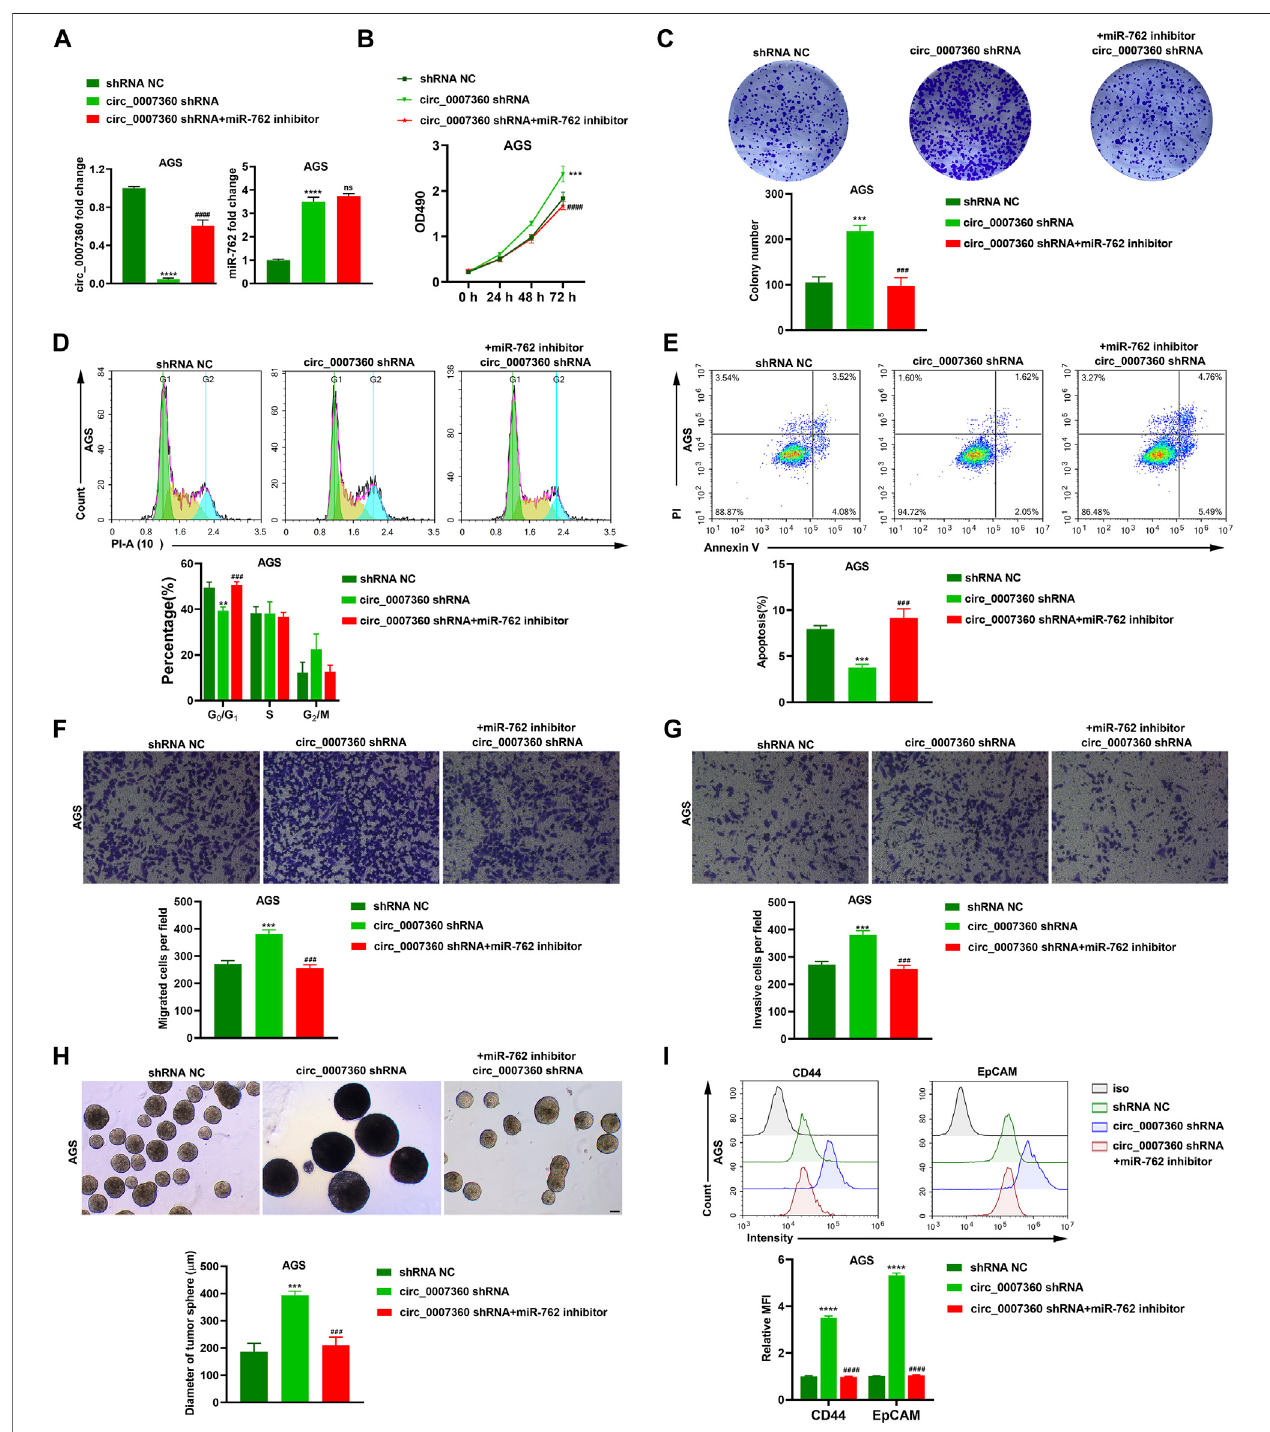
FIGURE 6 | Inhibition of miR-762 is responsible for the tumor-suppressive role of circ0007360 . (A) RT-qPCR analysis of circ0007360 or miR-762 expression with circ0007360 knockdown and miR-762 re-expression in AGS cells. (B) MTT assay in AGS cells with circ0007360 depletion and miR-762 re-expression. (C) Representativeimagesandquanti fi cationofcolonyformationassaysinAGScellswith circ0007360 knockdown and miR-762 re-expression. (D) Representativeimages and quanti fi cation of cell cycle analysis by fl ow cytometry in AGS cells with circ0007360 knockdown and miR-762 re-expression. (E) Representative images and quanti fi cation of cell apoptosis analysis using fl ow cytometry in AGS cells with circ0007360 knockdown and miR-762 re-expression. (F , G) Representative images and quanti fi cation of transwell results for detecting the migration (F) or invasion (G) in AGS cells with circ0007360 knockdown and miR-762 re-expression. (H) Representative images and quanti fi cation of tumor sphere formation results of stemness measured in AGS cells with circ0007360 knockdown and miR-762 re- expression. (I) Representative images and quanti fi cation of fl ow cytometry analysis of the expression of CD44 and EpCAM on the cell surface in AGS cells with circ0007360 knockdown and miR-762 re-expression.